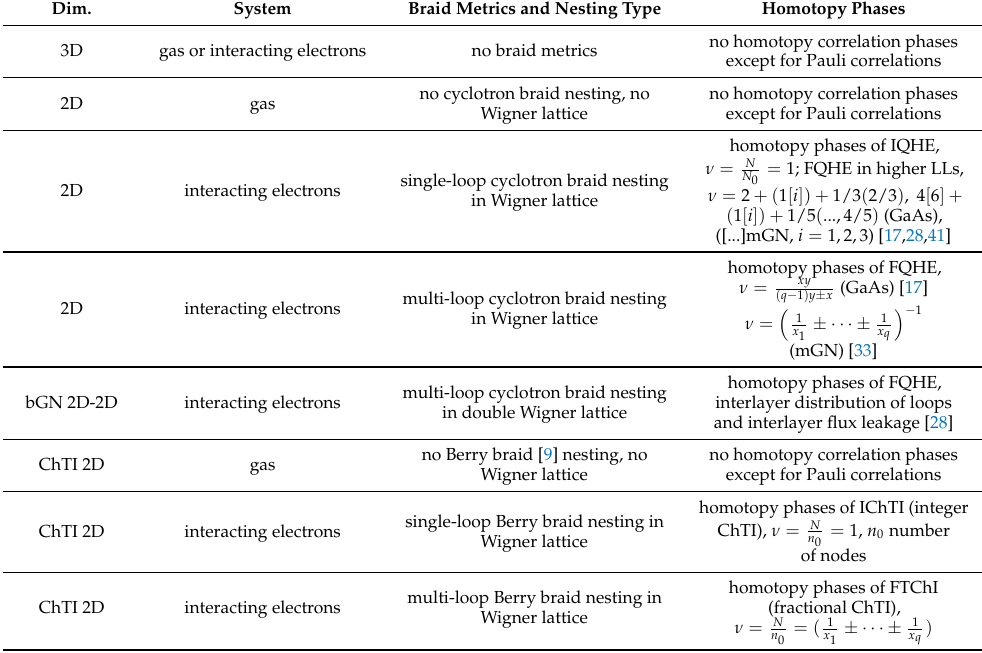
Table 1. Classification of multi-electron homotopy phases [m(b)GN—monolayer(bilayer)-graphene, ChTI—Chern topological